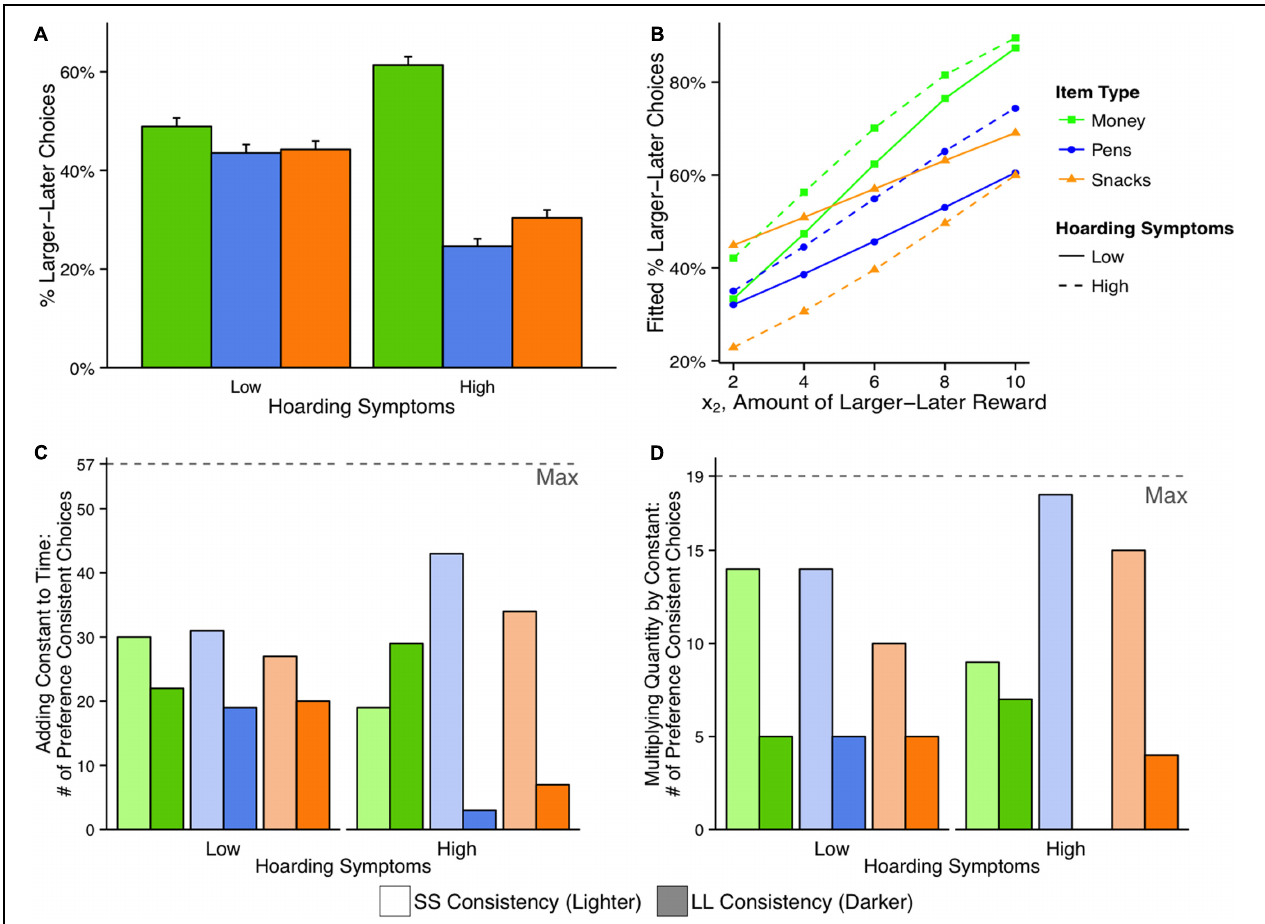
FIGURE 1 | Intertemporal discounting responses by group (high hoarding vs. low hoarding individuals) and domain (money, pens, snacks). Percent of participants choosing the larger-later (LL) option overall (A) ; effects of the increasing later reward amount with a fixed early reward and delay (B) ; effects of adding a constant to both times (C) ; effects of a constant multiplier (D) . In all plots, choices for money are represented with green coloration, pens in blue, and snacks in orange. For (B) , low hoarding individuals are represented by solid lines and high hoarding individuals are represented by dashed lines. For (C,D) , the number of times participants made consistent SS choices are in the lighter shade and the number of times participants made consistent LL choices are in the darker